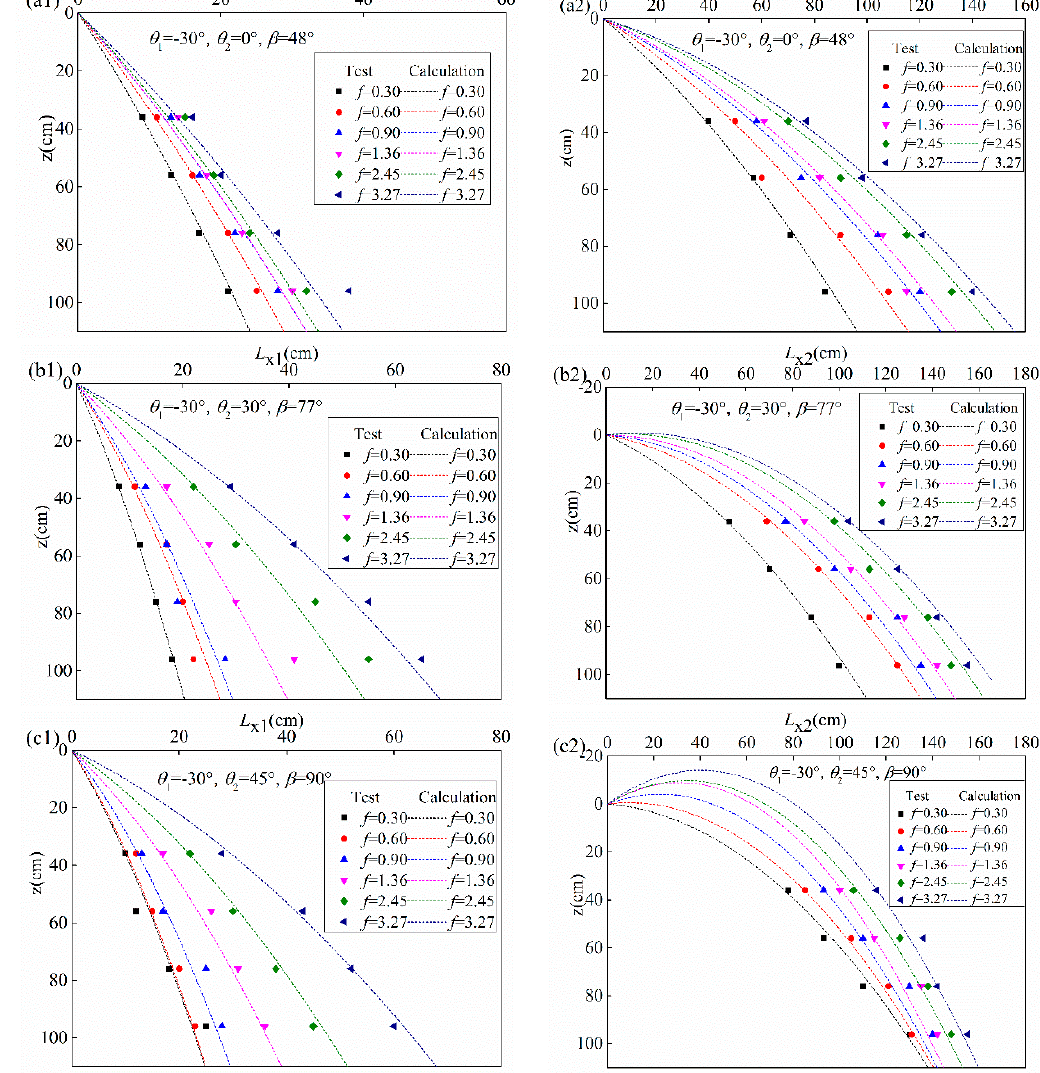
Figure 11. Comparison of the experimental and calculated values of L X1 and L X2 . L X1 is the distance of inner edge water tongue in x axis, L X2 is the distance of outer edge water tongue in x axis. ( a1 ) θ 1 = − 30 ◦ , θ 2 = 0 ◦ , and β = 48 ◦ ; ( a2 ) θ 1 = − 30 ◦ , θ 2 = 0 ◦ , and β = 48 ◦ ; ( b1 ) θ 1 = − 30 ◦ , θ 2 = 30 ◦ , and β = 77 ◦ ; ( b2 ) θ 1 = − 30 ◦ and θ 2 = 30 ◦ ; ( c1 ) θ 1 = − 30 ◦ , θ 2 = 45 ◦ , and β = 90 ◦ ; ( c2 ) θ 1 = − 30 ◦ , θ 2 = 45 ◦ , and β = 90 ◦